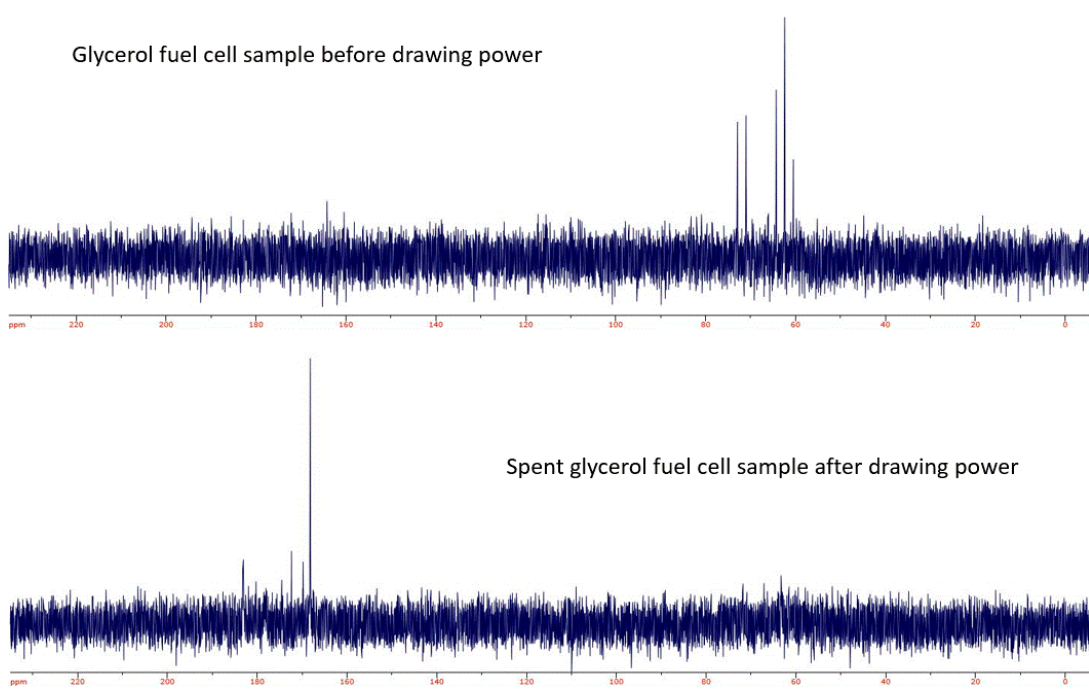
Figure A4. 13 C-NMR of a glycerol fuel cell solution before (above) and after (below) drawing power from the fuel cell. After the fuel cell solution is spent the signal for the glycerol falls into the noise and the emerging signals are consistent with carbonyl carbons.